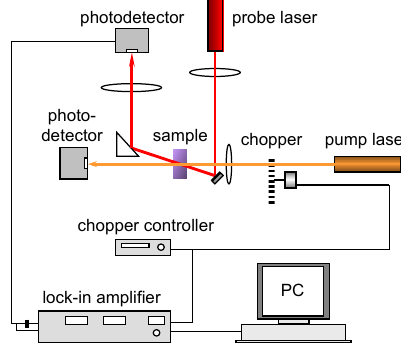
Figure 1. Schematic of the photothermal common ‐ path interferometry (PCI) experimental setup. The recorded signal is read from the crossing point of the pump and probe beams that move along the pump propagation direction, i.e. , perpendicular to the coating in the z ‐ direction (z ‐ scan) or across the coating in the x ‐ direction (x ‐ scan).